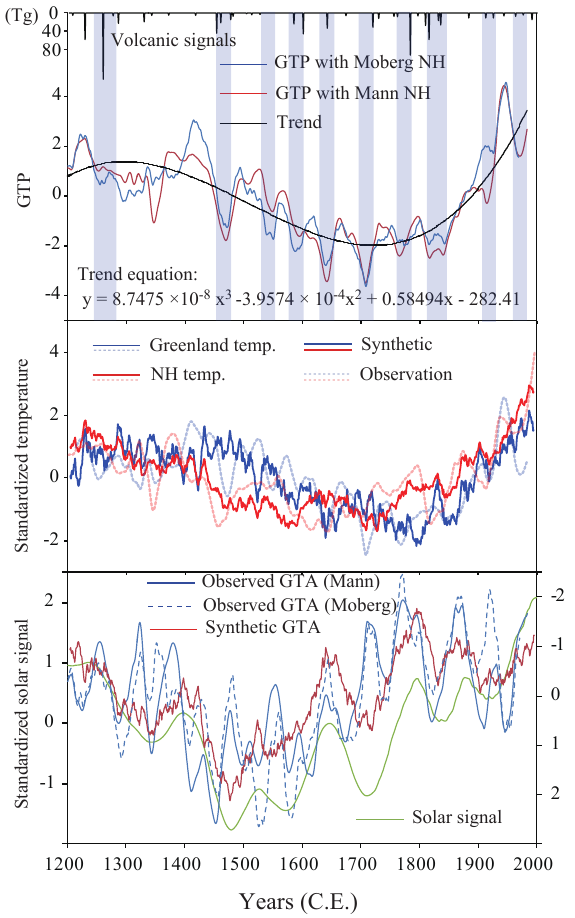
Fig. 6. Results of a simple numerical modeling. Top panel: GTP [ G+NH ] and millennial trend from polynomial regression of GTP [ G + NH ] with the NH temperature by Mann et al. (2009). The volcanic forcing for the NH from Gao et al. (2008) is plotted as a reference. Shaded areas are low GTP periods in the multidecadal- to-centennial time scale. Note that many shaded areas coincide with large volcanic eruptions. Middle panel: synthetic and observed Greenland temperature (Kobashi et al., 2010) and NH temperature (Mann et al., 2009). Bottom panel: synthetic GTA [ G − NH ] , observed GTAs [ G − NH ] with the NH temperatures by Mann et al. (2009) and Moberg et al. (2005), and standardized solar forcing (solar 2 in Fig.